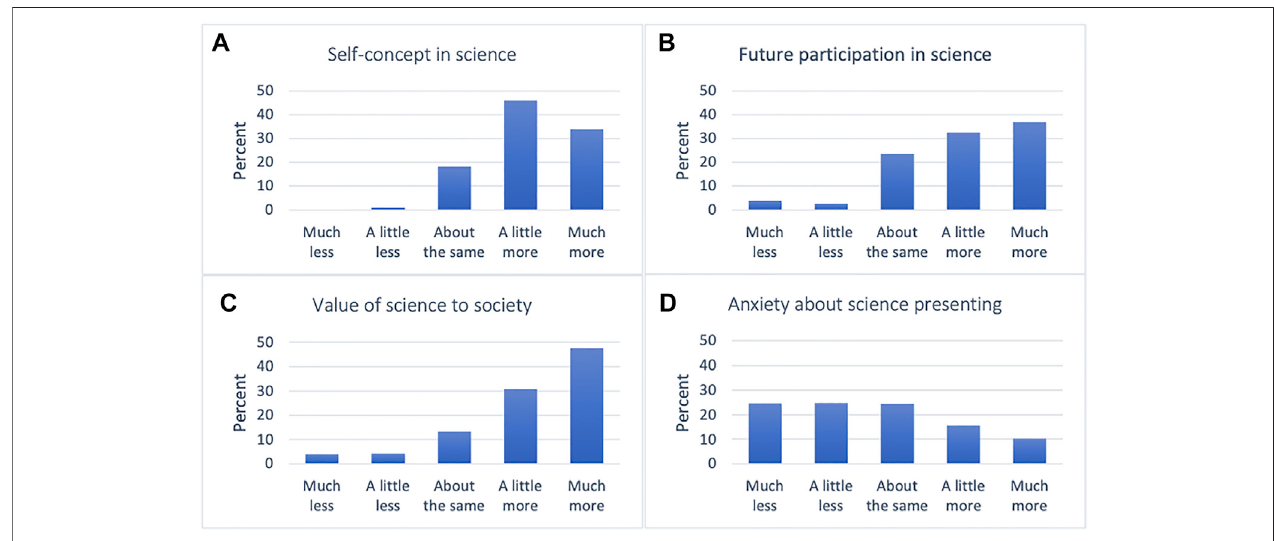
FIGURE 2 | Alumni presenters ’ retrospective rating (percentage; n = 678) of how being a presenter had impacted their attitudes towards science in four scales: Self-concept in science (A) ; Future participation in science (B) ; Value of science to society (C) ; and Anxiety about science presenting (D) .